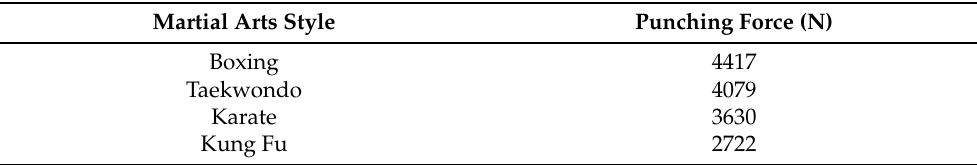
Table 1. Fight Science martial arts punching comparison experiment.